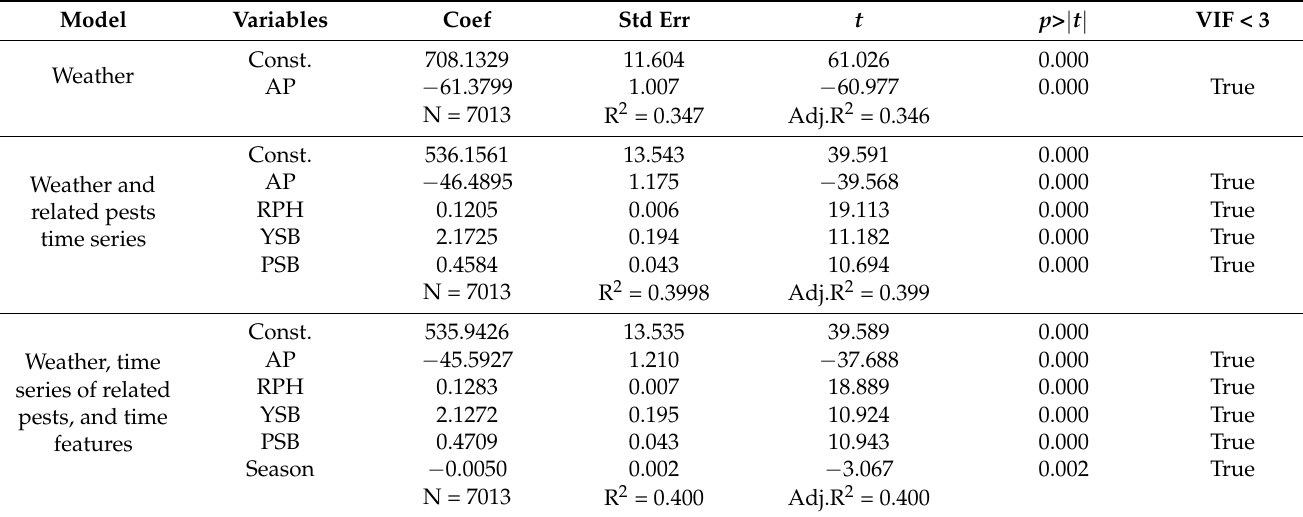
Table 7. Statistical diagnostics of the stepwise multiple linear regression models (taking the Yuanjiang SRSB as an example).